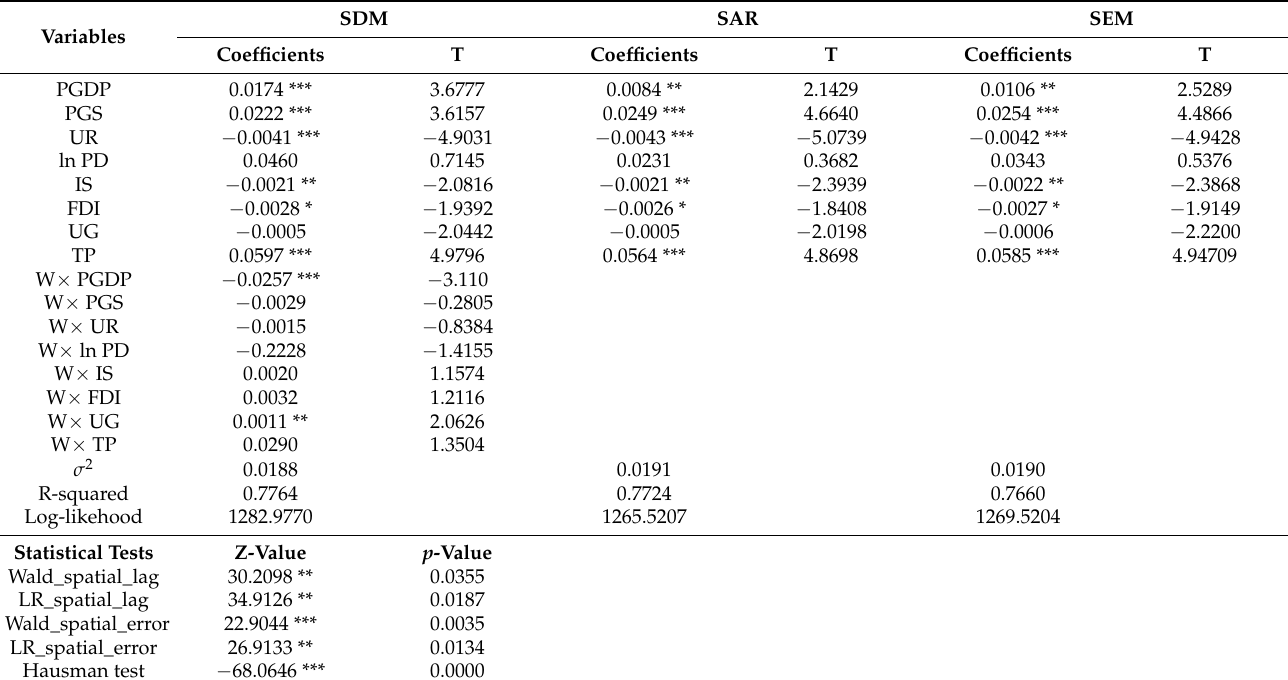
Table 5. The spatial effect panel regression results of the